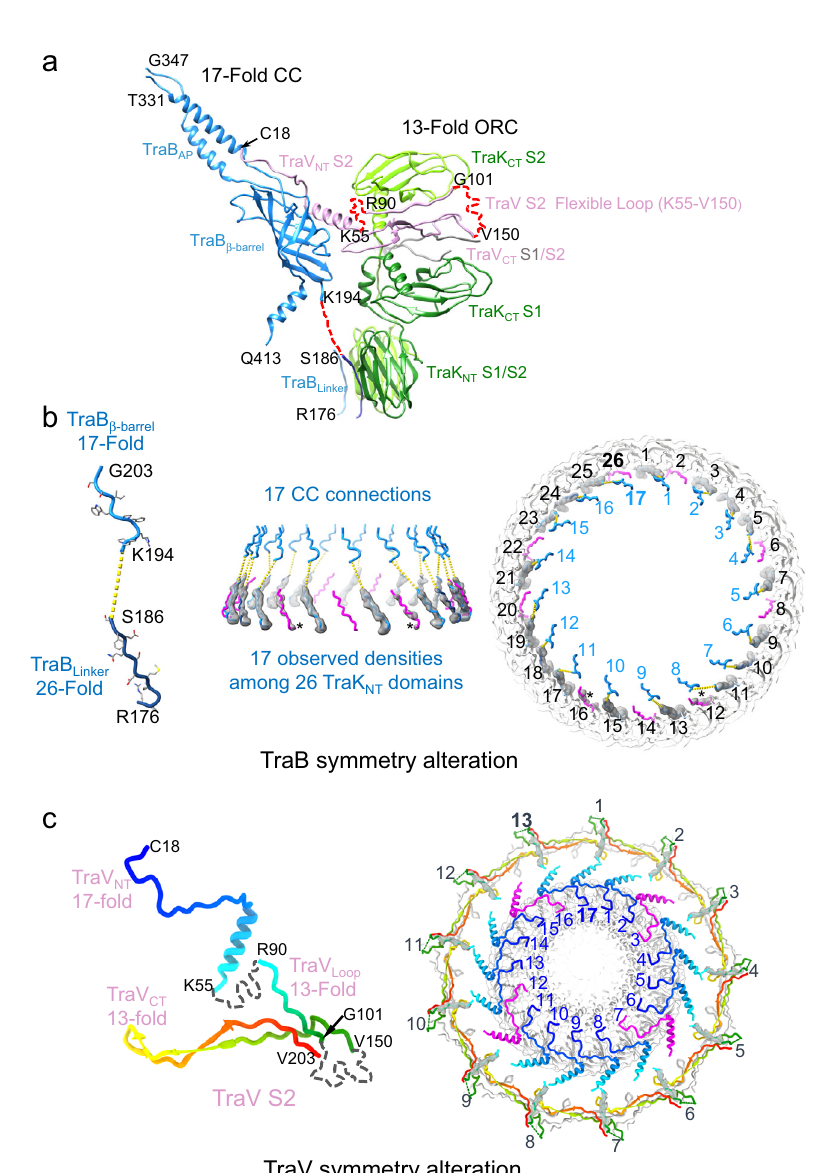
Fig. 4 TraV and TraB accommodate the C13:C17 symmetry mismatch. a An asymmetric unit of the OMCC F . Thirteen TraK/TraV CT units comprise the C13 ORC, while the 17 TraB β -barrel/ TraV NT units assemble as the C17 CC. TraV and TraB bridge the ORC and CC substructures through fl exible loops (red dash lines). Subunit domains and colors are shown as described in Fig. 2 legend. Residues shown denote boundaries of the different domains. A short segment (residues R90-G101) in the TraV S2 fl exible linker forms a traceable contact with the TraK CT S2 domain. Two TraB R176-S186 linker segments are shown to denote detectable contacts with both S1 and S2 domains of the TraK NT dimer. b Left: Segment of TraB involved in the intraprotein symmetry alteration. Residues K194-G203 are part of the TraB β -barrel domain, 17 copies of which form the CC. Residues S186-K194 bridge the symmetry mismatch, but can be deleted without affecting T4SS F function. Residues R176-S186 bind a subset of the 26 copies of TraK NT domains comprising the ORC. Middle and Right: Schematic views depicting the TraB symmetry alteration from side and top, respectively. Color-coding is as shown at left. Densities (gray) are extracted from the C1 reconstruction, which shows 17 strong densities (blue sites), 7 empty densities (magenta sites), and 2 weak densities (* at sites #12 and 16, magenta). Numbers refer to the 26 TraK NT domains and 17 connections to the TraB β -barrel domains. c Left: TraV monomer (Rainbow color) displays an intraprotein symmetry alteration. A subset of the 26 TraV NT (residues C18-K55) bind 17 available sites in the CC. The fl exible loop (residues K55-V150) bridges the symmetry mismatch, but can be deleted without affecting T4SS F function. Twenty-six copies of the TraV CT domain (residues V150-N204) comprise the ORC belt. Residues R90-G101 in the fl exible loop associated with TraV S2 bind the 13 copies of TraK CT -S2 domains. Right: Schematic view depicting the TraV intraprotein symmetry alteration viewed from top. Densities associated with the traceable R90-G101 segment from TraV S2 are shown. The 4 magenta-colored TraV NT domains (randomly selected) have no traceable paths to TraV CT domains. The 13 TraV NT S2 domains (blue) are connected via the fl exible loop to the TraV CT -S2 domains (rainbow). TraB β -barrels comprise the CC (gray, inner ring). TraV NT -S1 domains connected to the TraV CT -S1 domains (gray, outer ring) have not been identi fi